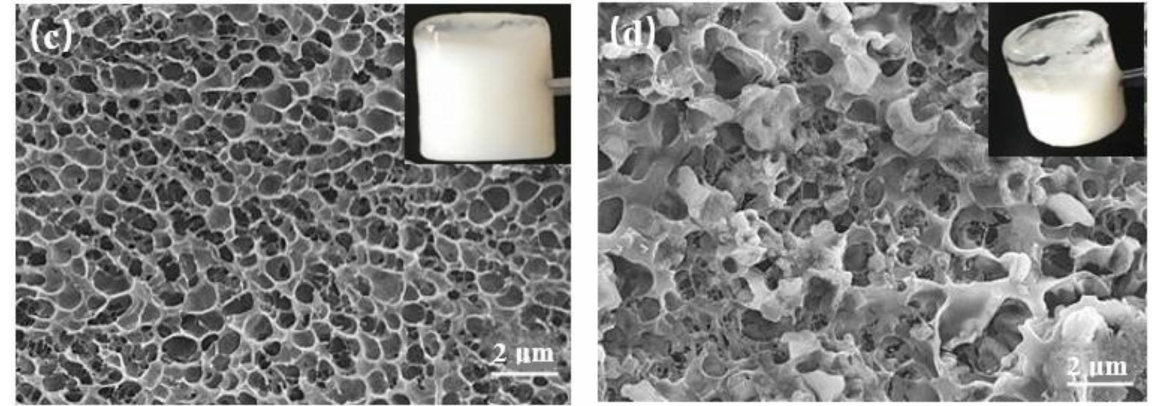
Figure 12. Micromorphology of shear thixotropic gel in different salt water concentrations: ( a ) 10,000 mg/L NaCl; ( b ) 100,000 mg/L NaCl; ( c ) 1000 mg/L CaCl 2 ; ( d ) 10,000 mg/L CaCl 2